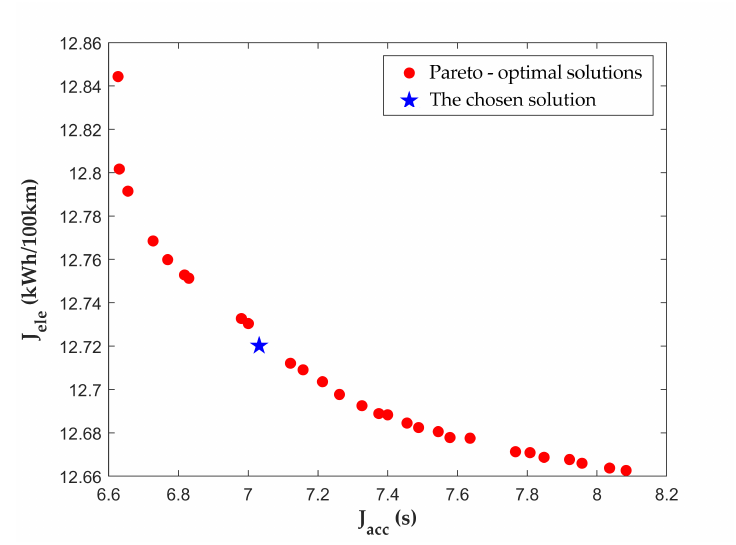
Figure 6. The Pareto front graph between the acceleration time and electricity consumption. Table 3. The results for the chosen gear ratio combination and the single gear ratio. WLTP—World Light Vehicle Test Procedure.